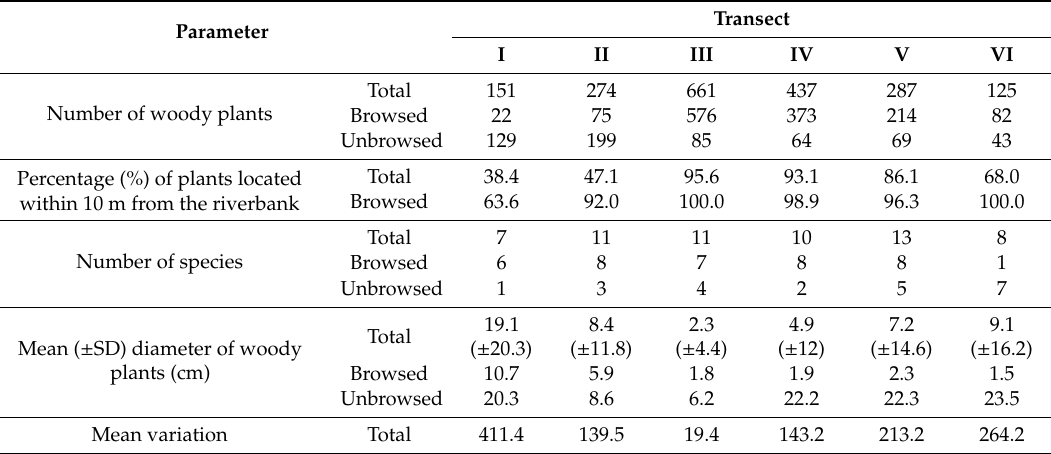
Table 3. Descriptive statistics and characteristics for the woody plants in transects with di ff erent human disturbance levels, inventoried for the beavers’ ( Castor fiber) foraging preference assessment on Gwda